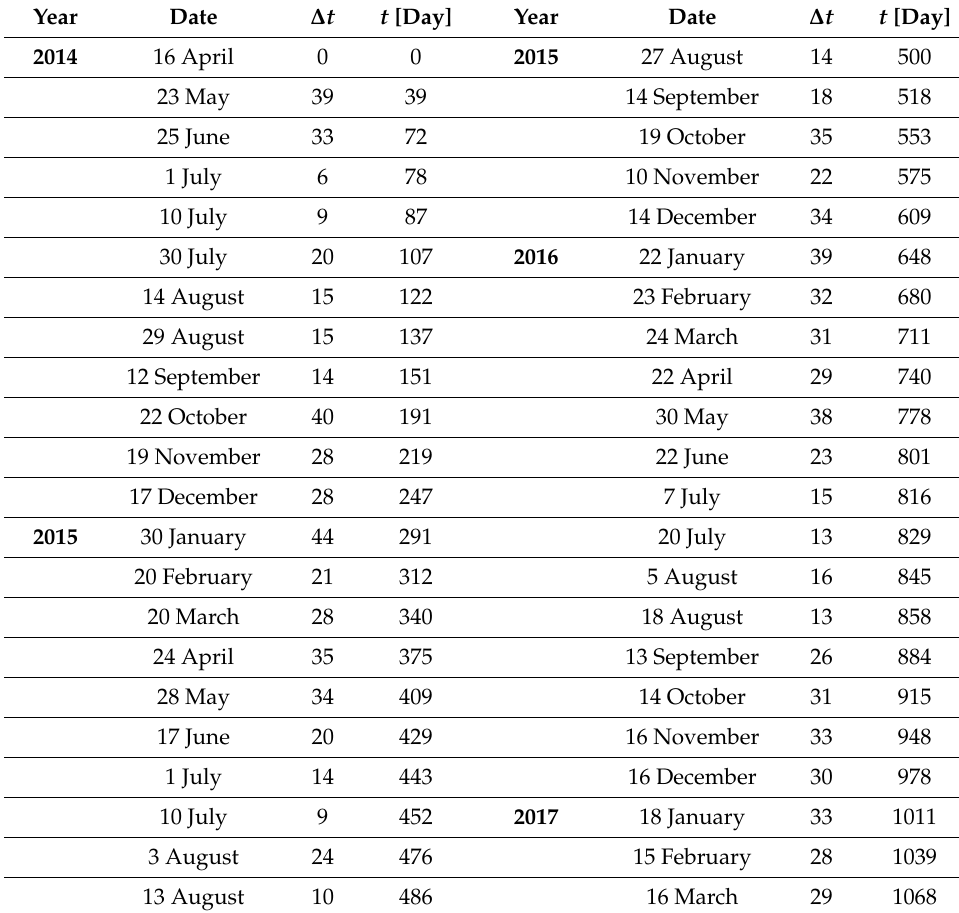
Figure 6 indicates the temperatures at a depth of 3.0 m under the asphalt layer during the three-year period. The temperatures vary from 2.9